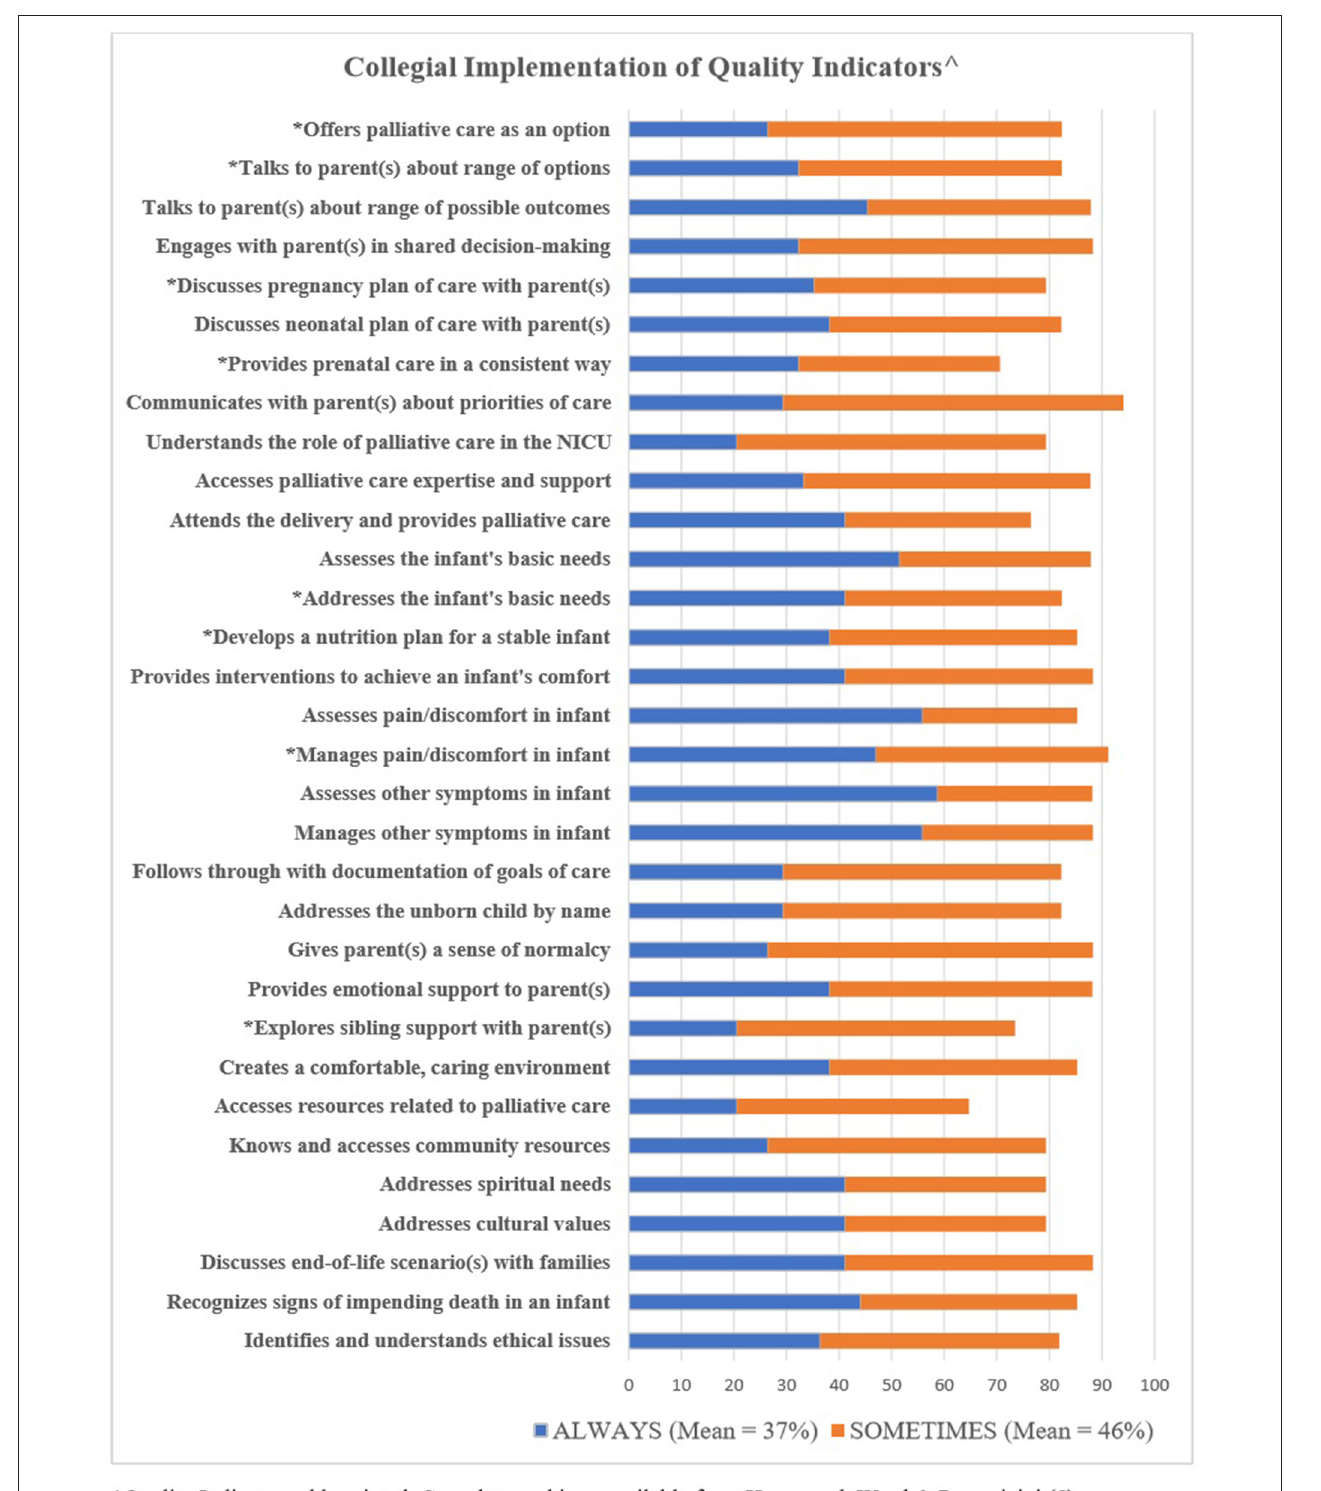
FIGURE 3 | Collegial implementation of quality